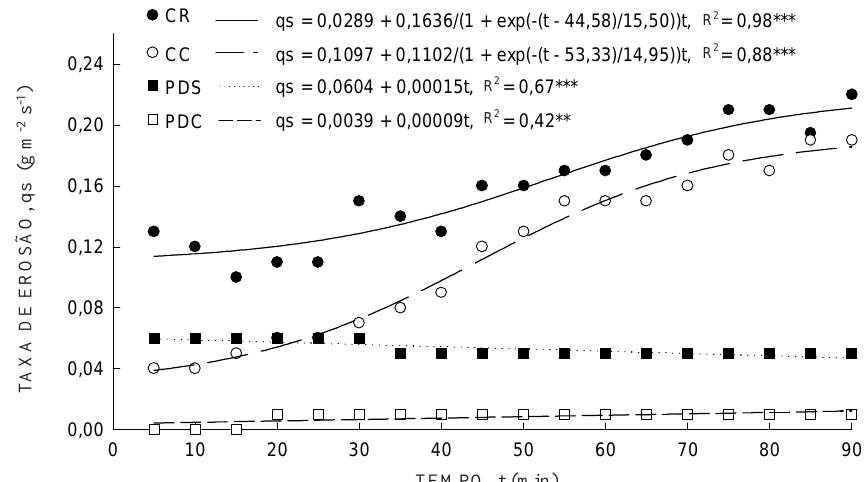
Figura 3. Taxa de erosão (qs) em função do tempo ( t ) de aplicação da chuva, em diferentes preparos e consolidação do solo (CR = convencional recente, CC = convencional consolidado, PDS= plantio direto sem palha, PDC = plantio direto com palha). *** = P < 0,0001; ** = P < 0,001.